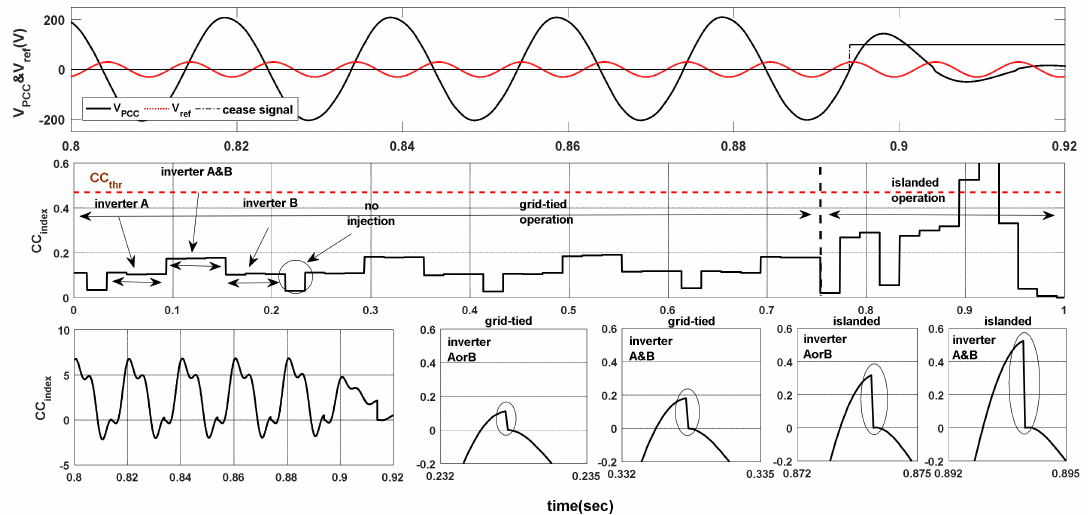
Figure 12. ( top graph ) V PCC along with V ref , ( middle graph ) evolution of CC index in grid tied and islanded operation, ( bottom graph ) evolution of the CC index